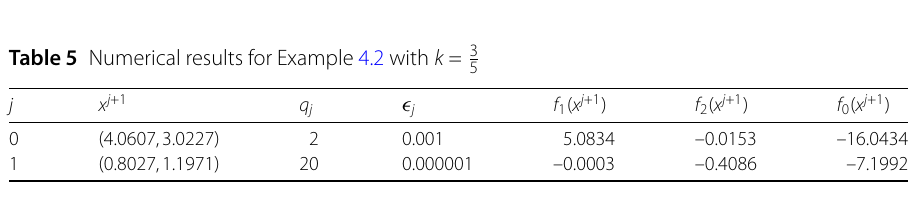
Table 5 Numerical results for Example 4.2 with k = 3